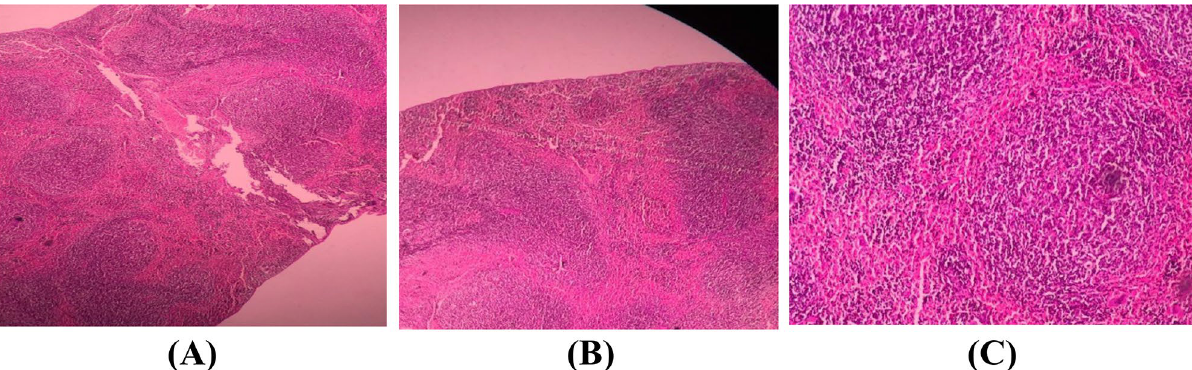
Figure 3. The histological effect of CH and DZN on the BALB/c spleen changes induced by DZN in studied groups. The mice spleen section in control group ( A ), DZN (20 mg/kg) group ( B ), and DZN plus CH 50 mg/ kg ( C ). The impact of CH on the spleen in DZN treated and untreated mice showed significant extra-medullary hematopoietic congestion. There were no significant histopathologic changes among the studied groups. Hematoxylin and Eosin (H&E) staining, × 400 magnification.